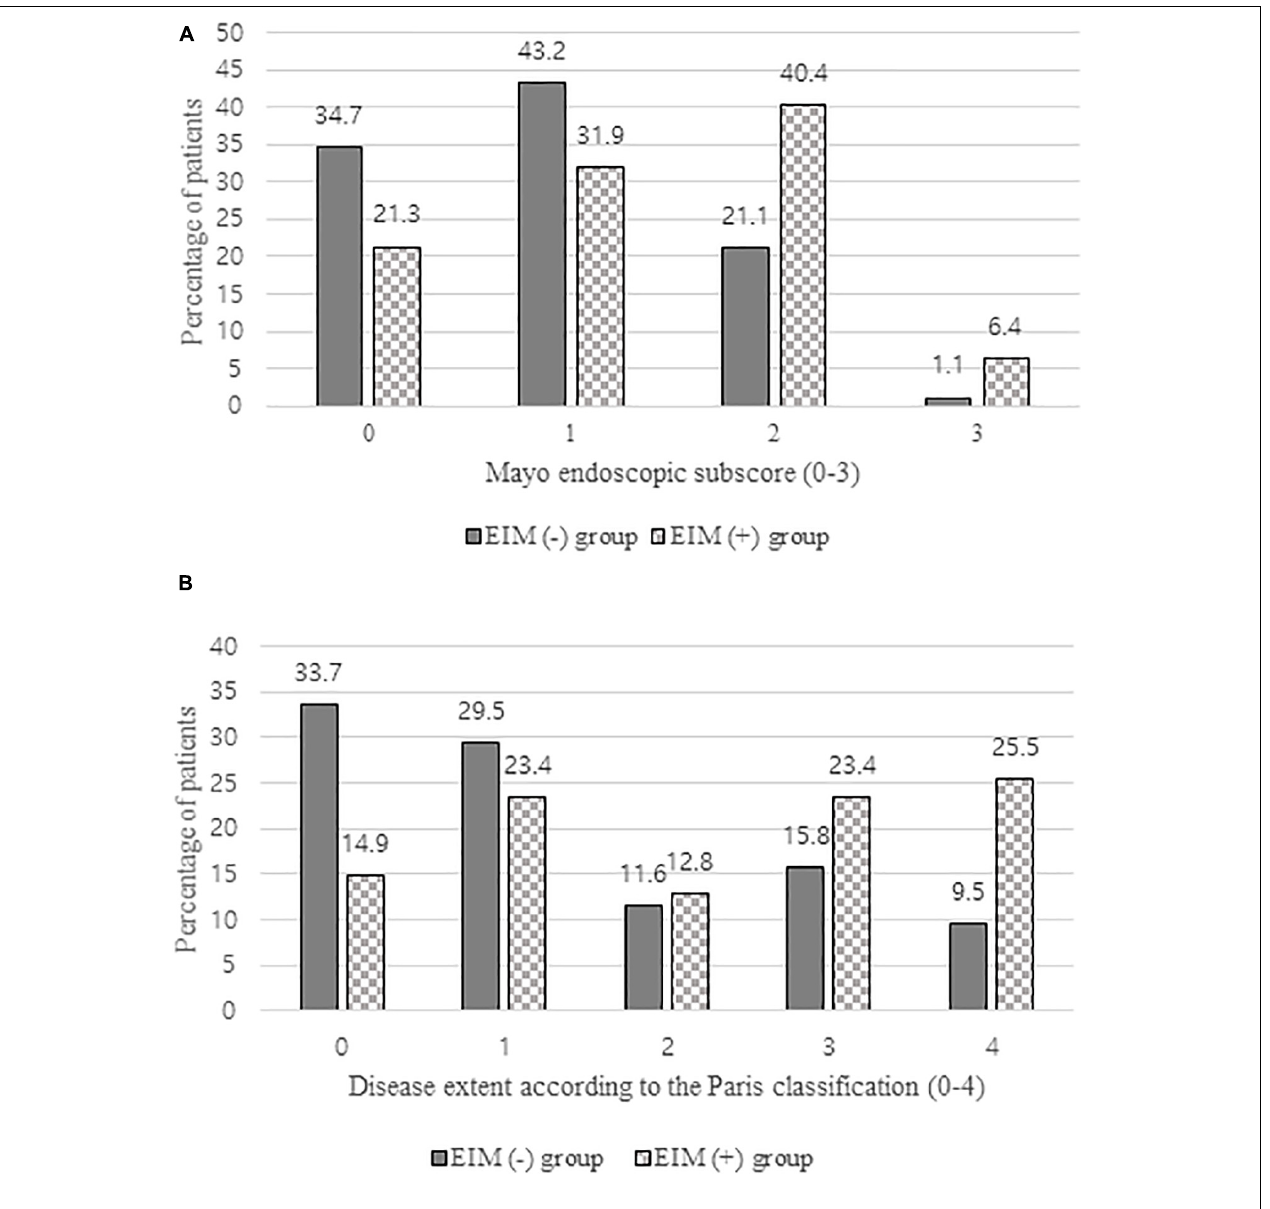
FIGURE 4 | (A) Comparison of mayo endoscopic subscore of EIM (+) group and EIM ( − ) group evaluated by colonoscopy 1 year after the diagnosis. (B) Comparison of disease extent of EIM (+) group and EIM ( − ) group according to the Paris classification evaluated by colonoscopy 1 year after the diagnosis. EIM, extraintestinal